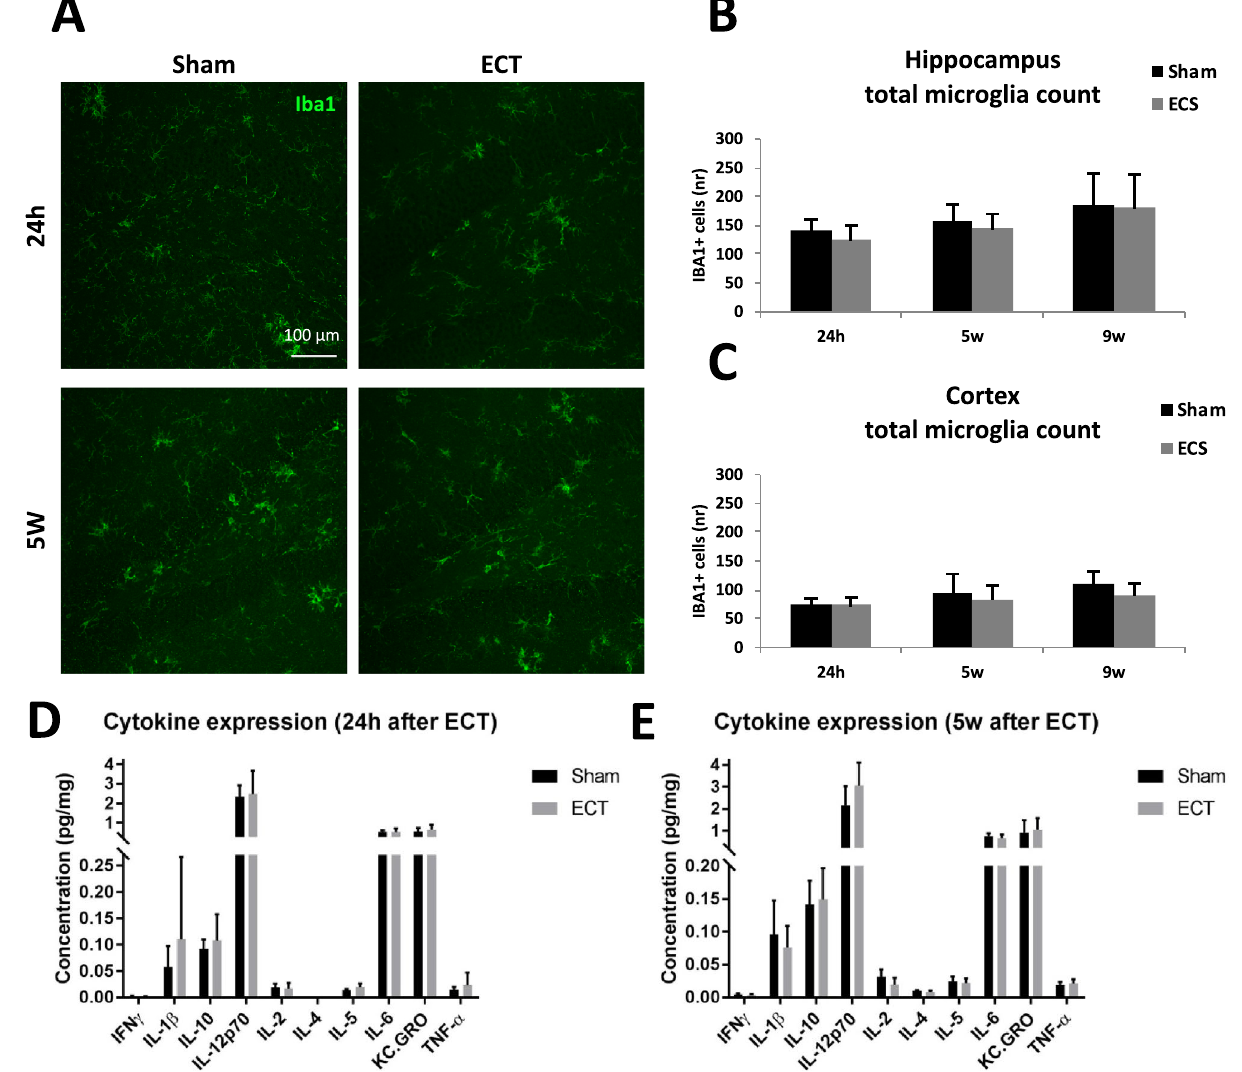
Figure 2. Effects of ECS on microglial activity. ( A ) Representative confocal microscopy images (20 × visualising Iba1 staining in dentate gyrus. Scale bars represent 100 μm. Quantification of microglial cells in ECS and sham groups sacrificed 24 h, 5 w and 9 w after last ECS session in ( B ) hippocampus and ( C ) cortex. Images were analyzed with the free version ImageJ 1.52 (https ://image j.nih.gov/ij/). Levels of pro/anti-inflammatory cytokines in the hippocampus ( D ) 24 h and ( E ) 5 w after last ECS session. Bars represents mean values with error bars displaying SD. Analyses were done by unpaired T-test ( p ≤ 0.05*). For the 24 h groups, n = 8 for sham and n = 7 for ECS. For the 5 weeks groups, n = 9 for sham and n = 9 for ECS. For the 9 weeks groups, n = 5 for sham and n = 6 for